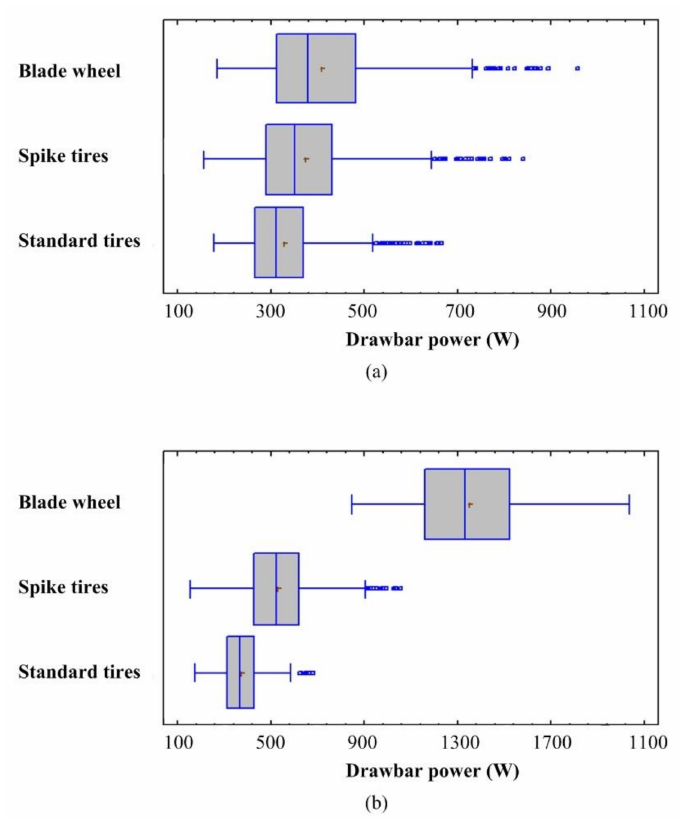
Figure 8. Box-and-whisker plot: ( a ) low load; ( b ) high load. The rotation speed of driving wheels n w = 0.41 s − 1 was calculated according to Equation (5) using the gear ration ( i 2 = 146.3) of the second gear and rated engine speed of the test tractor ( n e = 3600 min − 1 ). The model frequency interval was calculated according to Equations (6) and (7).